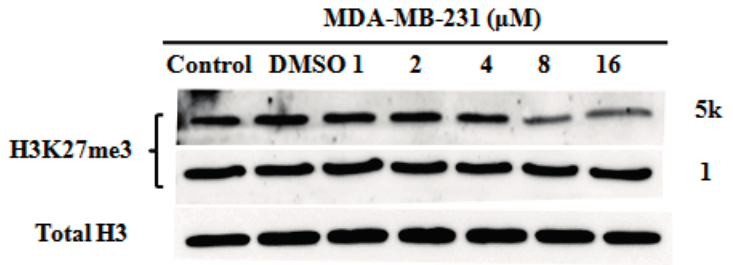
Figure 3. Analysis of H3K27 methylation in MDA-MB-231 cell line treated with 1 and 5k . Evaluation of H3K27me3 following treatment for 72 h. Total H3 is shown as a loading control.